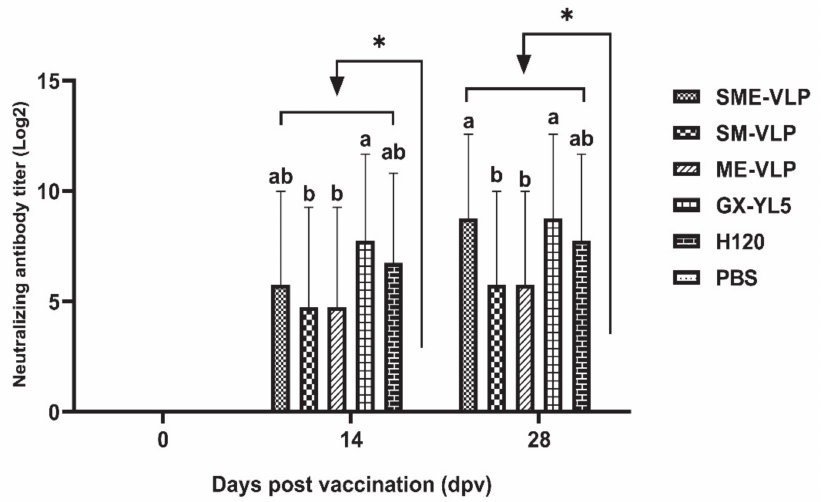
Figure 7. IBV-neutralizing antibodies measured in sera (0, 14 and 28 dpv) by trachea organ ring (TOC) neutralization test. Letters (a,b) indicate significant differences among vaccinated groups ( p < 0.05). * indicates p < 0.05 between vaccinated and nonvaccinated groups. ( n = 10